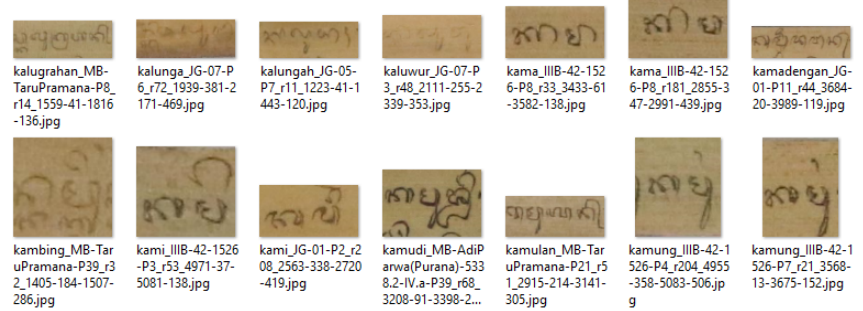
Figure 18. Balinese word dataset.